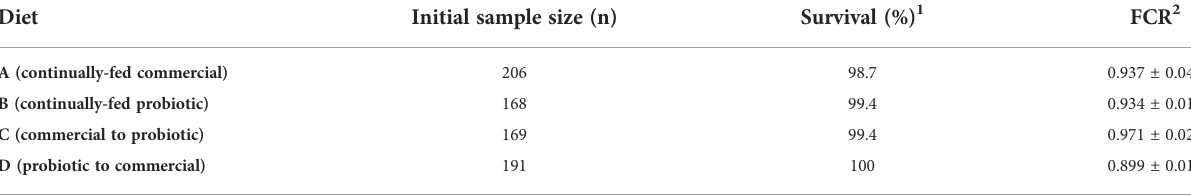
TABLE 1 Production period (T2 to T3) measurements of steelhead trout following probiotic